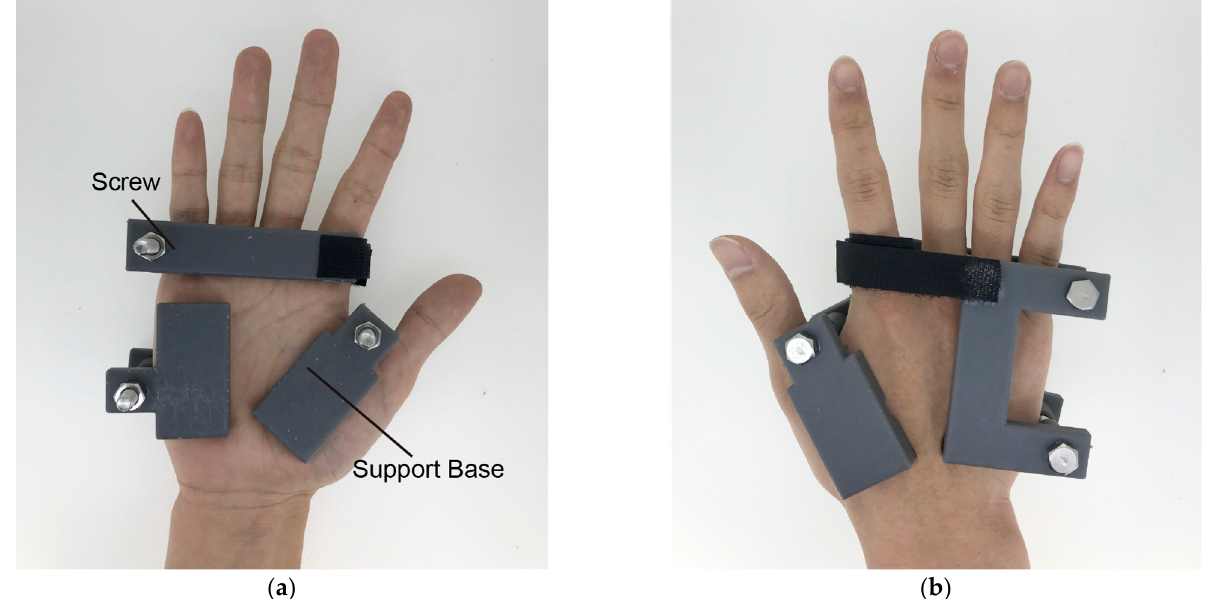
Figure 2. Photograph of proposed haptic glove: ( a ) palm side and ( b ) back side of the hand.